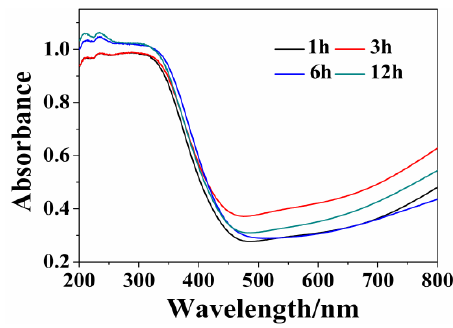
Figure 6. UV-Vis diffuses reflectance spectra of the products prepared under different solvothermal reaction times.